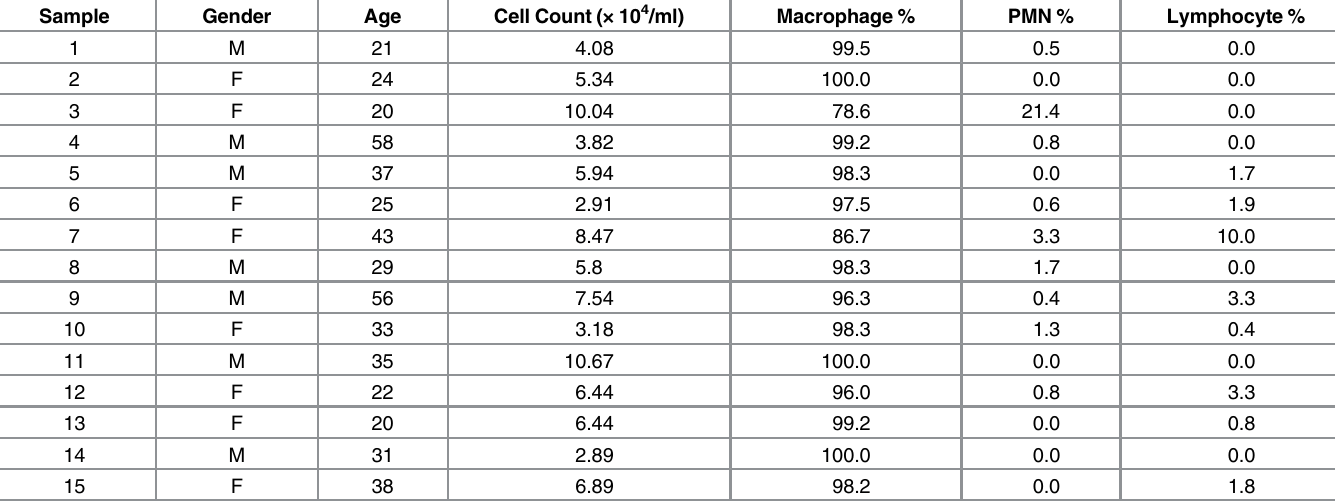
BAL samples from consecutive healthy volunteers who met the inclusion and exclusion criteria were included and no samples were excluded in the cell count and differential analysis. Gender, age, cell counts and differentials are depicted. Immunophenotyping by fl ow cytometric analysis was conducted with presence or absence of ultrapure LPS using cells obtained from the subsequent consecutive healthy volunteers 11 –